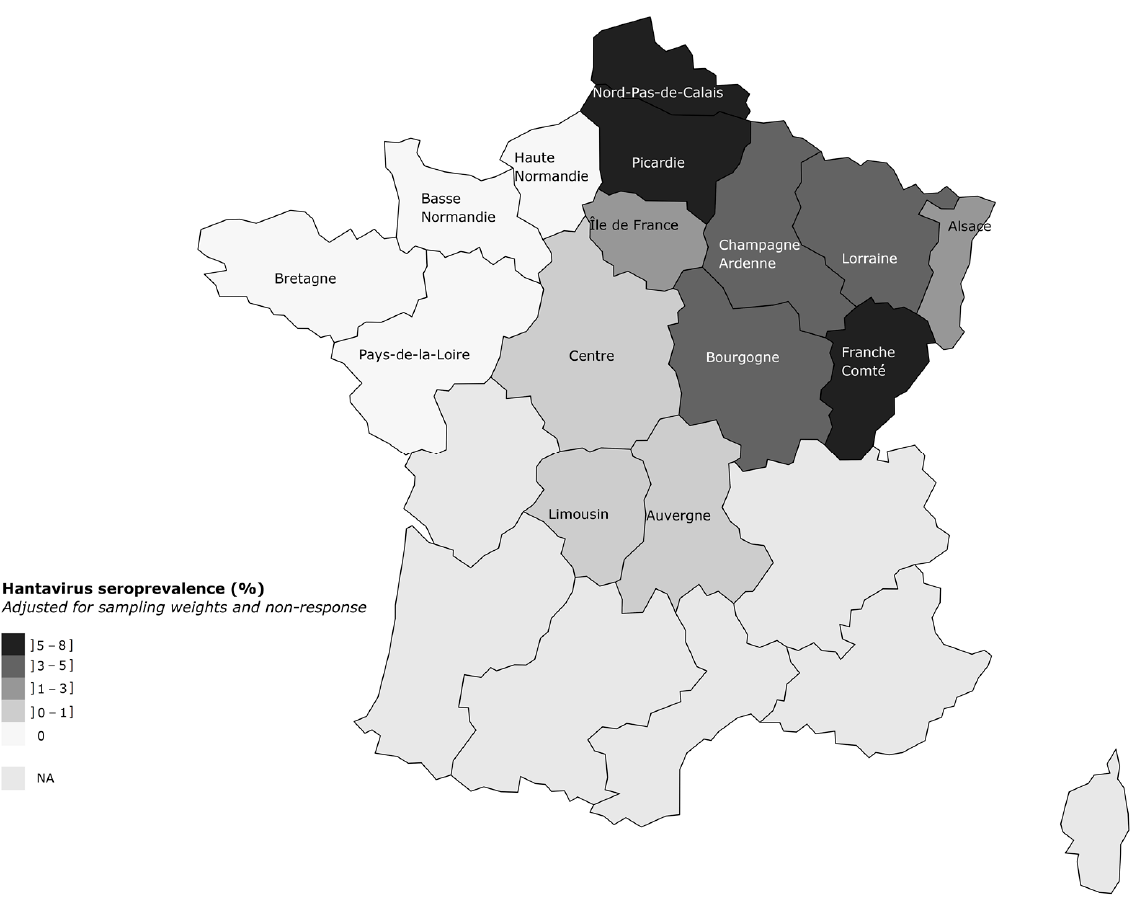
Figure 1. Adjusted prevalence of immunoglobulin G against Puumala orthohantavirus antigens among forestry workers in northern France, 2019–2020.